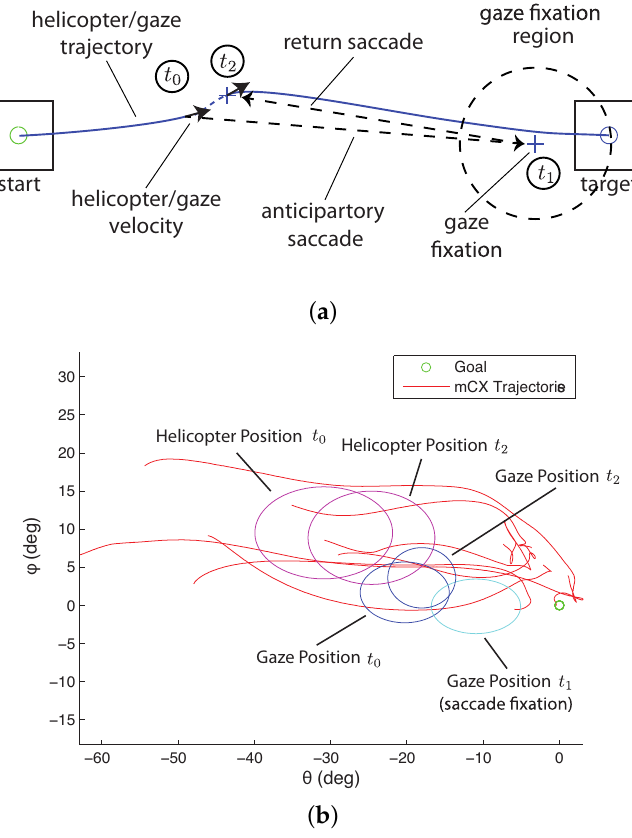
Figure 16. Description of the saccade dynamics during the step task. The ellipsoids are based on mean values for the position variables along with the 1 σ error bounds for the step task. ( a ) Key variables involved in saccades to a target; ( b ) Statistics extracted from the step